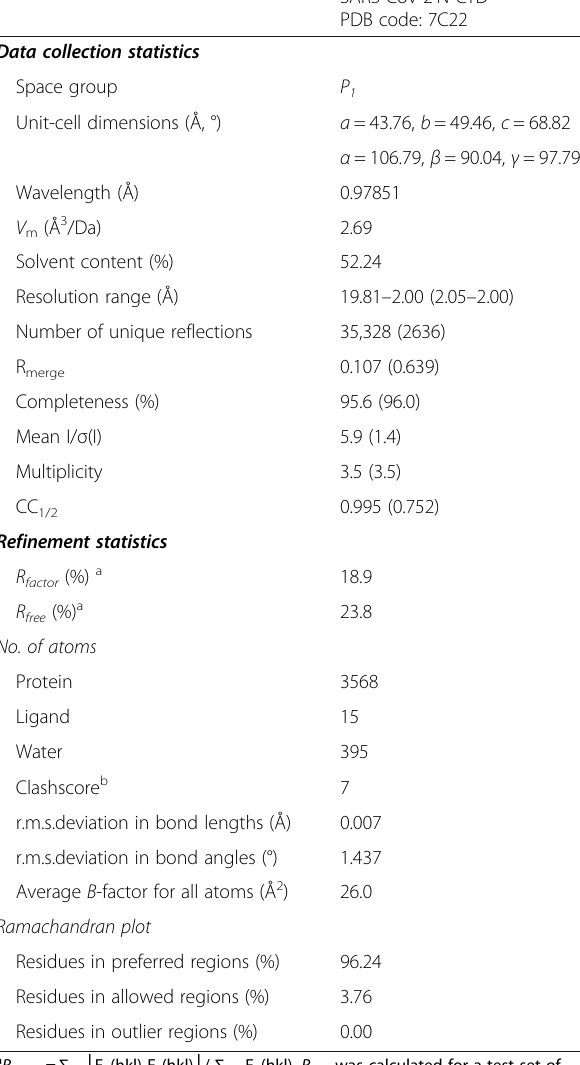
Table 1 Data collection and refinement